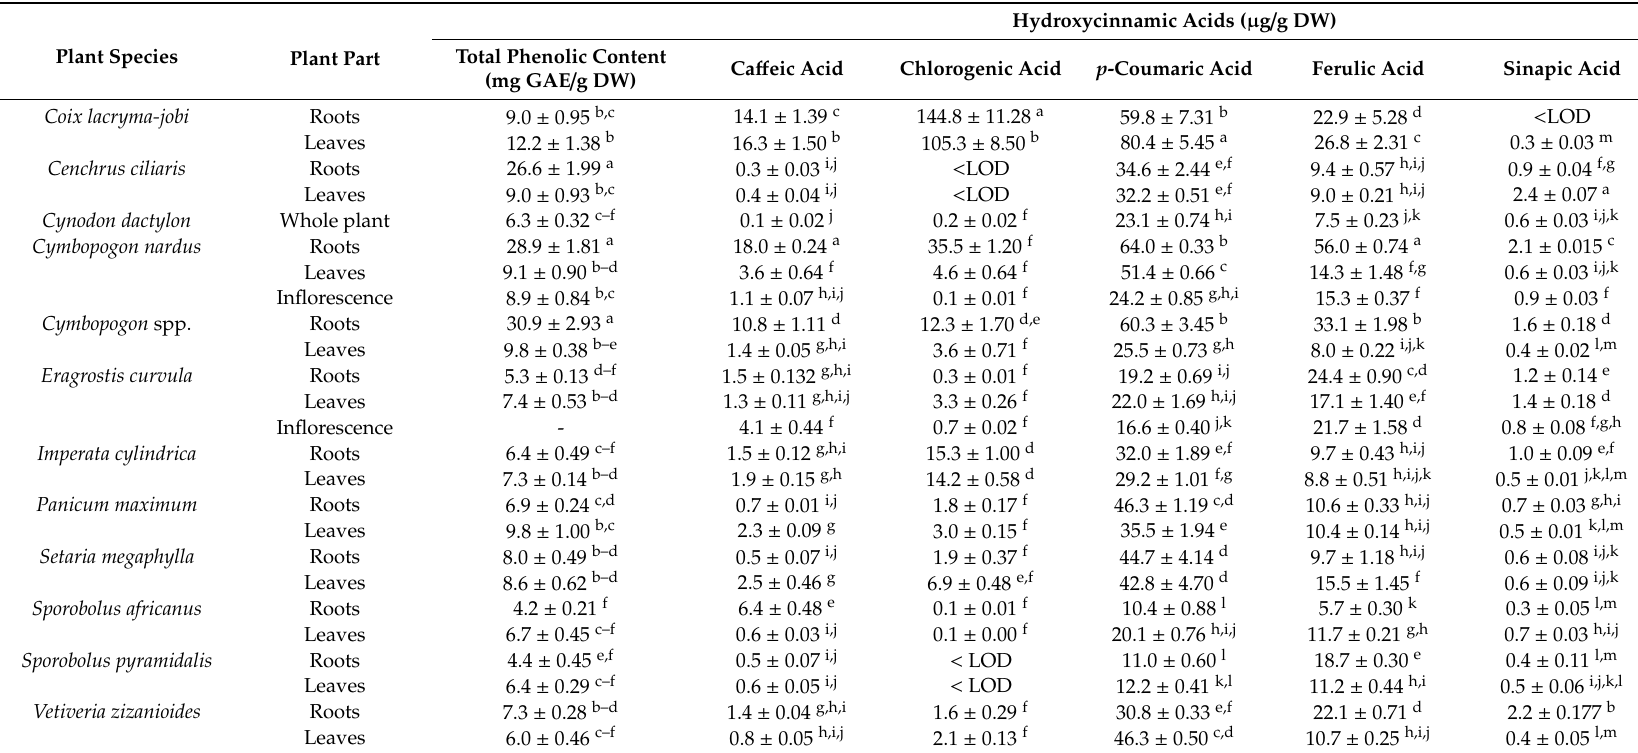
Table 2. Quantity ( µ g / g DW) of hydroxycinnamic acids in 80% methanolic extracts of di ff erent grasses. Values represent mean ± standard error, n = 3. In each column, values with di ff erent letter(s) are significantly ( p ≤ 0.05) di ff erent, based on Duncan’s multiple range test (DMRT). < LOD = below level of